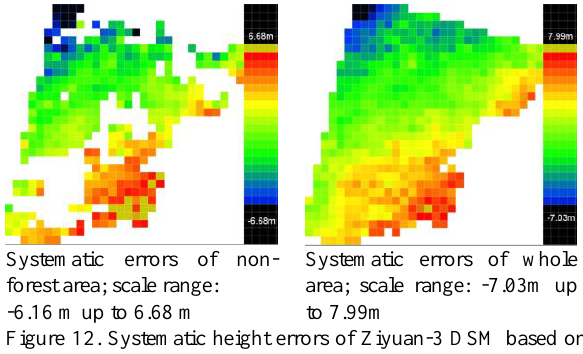
4. HEIGHT MODELS FROM PLEIADES-1A